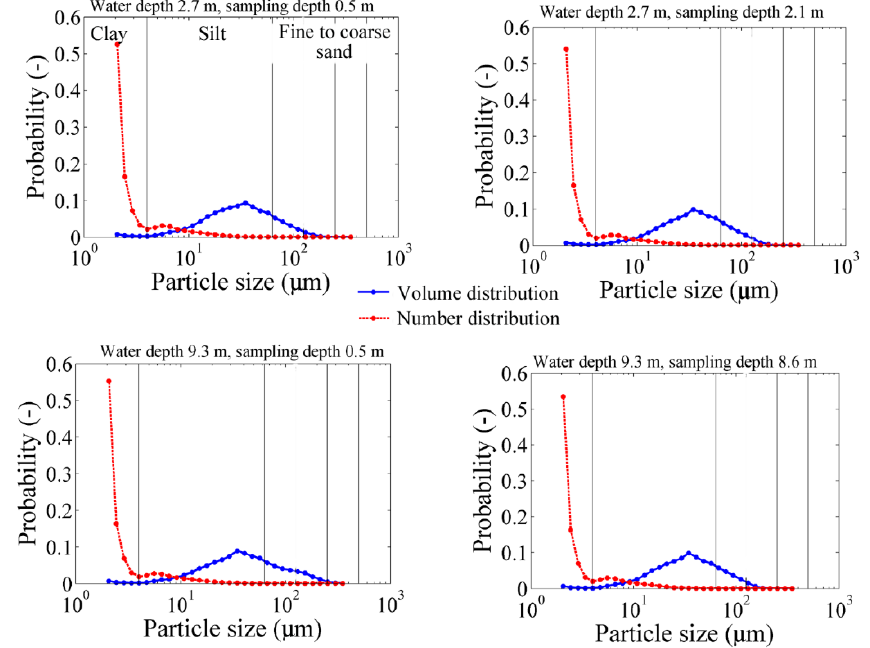
Figure 4. Subset of four PSDs (two minutes averaged) from LISST-SL point measurements in two verticals with different water depths in the Danube River at Esztergom.